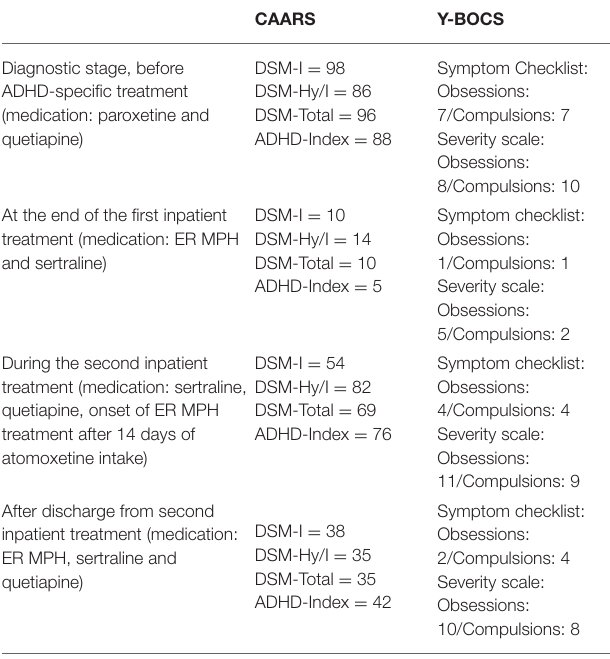
TABLE 2 | The patient’s scores on CAARS (in percentile rank) and Y-BOCS. CAARS